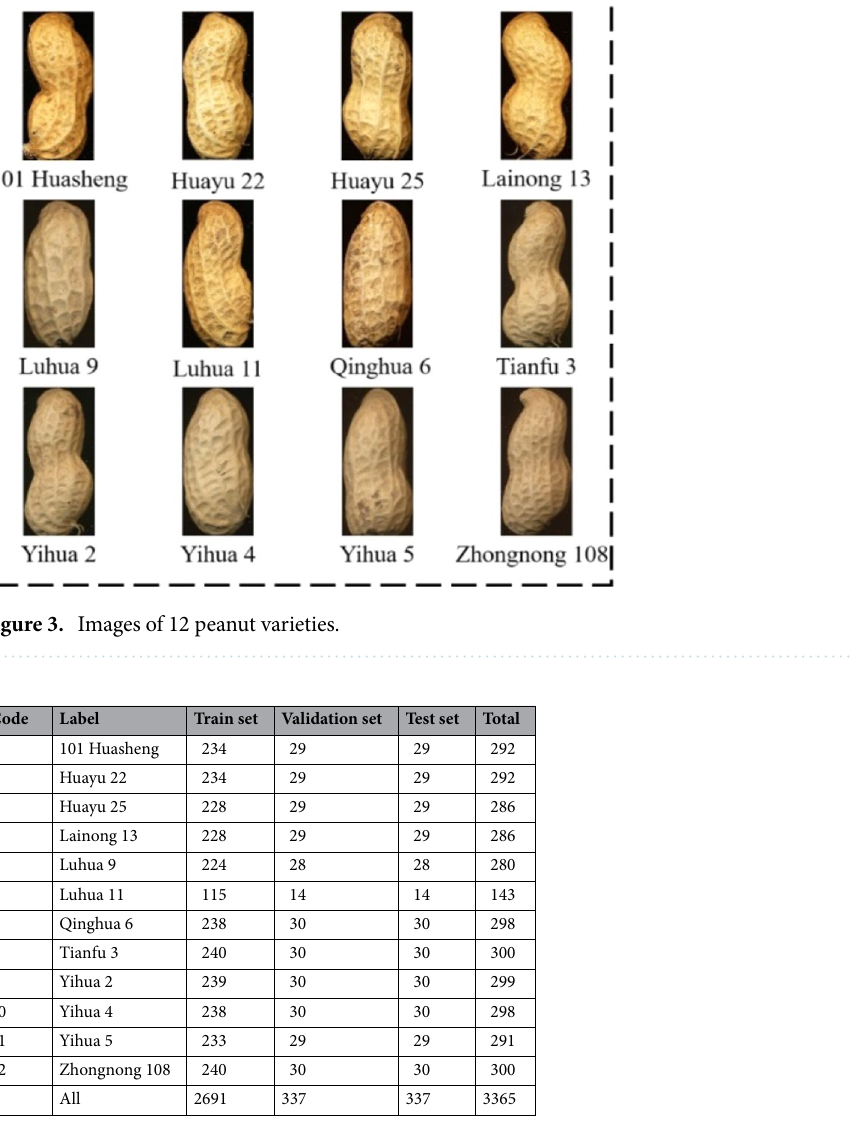
Table 2. Peanut pod identification data